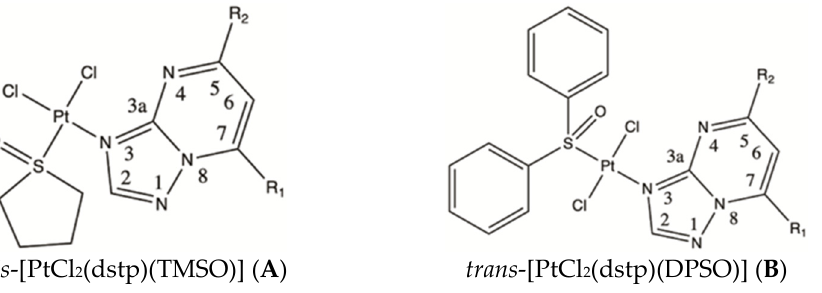
Figure 1. Structures of novel dichloride platinum(II) complexes. The structures contain tetrahydrothiophene-1-oxide (TMSO) for cis isomers ( A ) and diphenyl sulfoxide (DPSO) for trans isomers ( B ). IUPAC numbering of 1,2,4-triazolo[1,5- a ]pyrimidine derivative is displayed. ( A1 , B1 ) R 1 , R 2 =